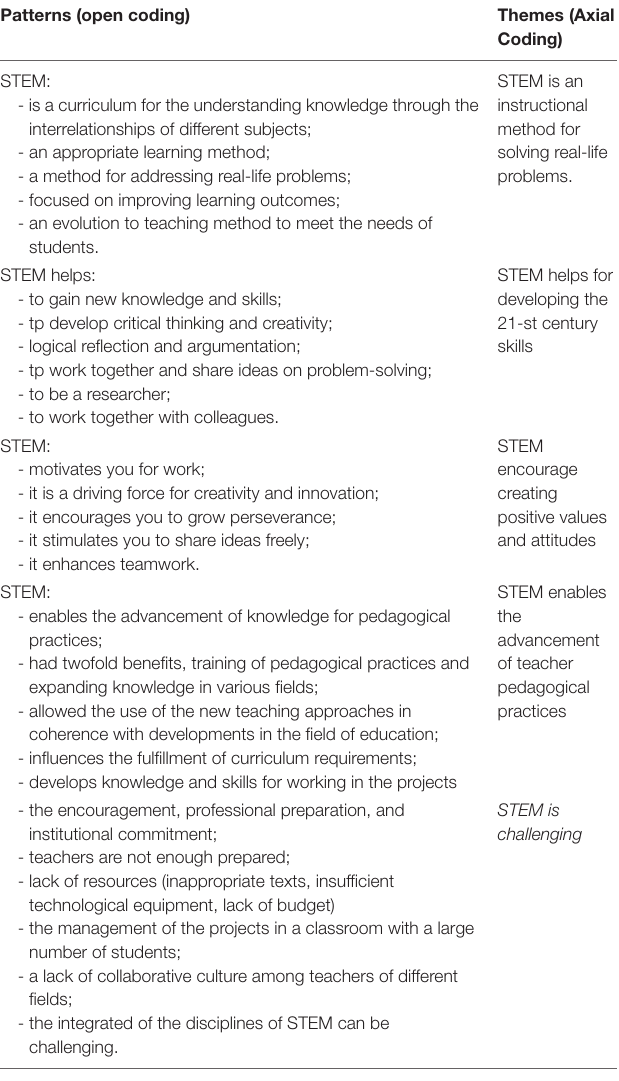
TABLE 2 | Summary of Patterns and Themes that emerged from the responses of the reflective question: How do you understand STEM education? How does STEM influence enhancement of your pedagogical practices? What are benefits/challenges of applying and implementing STEM education? Patterns (open coding) Themes (Axial